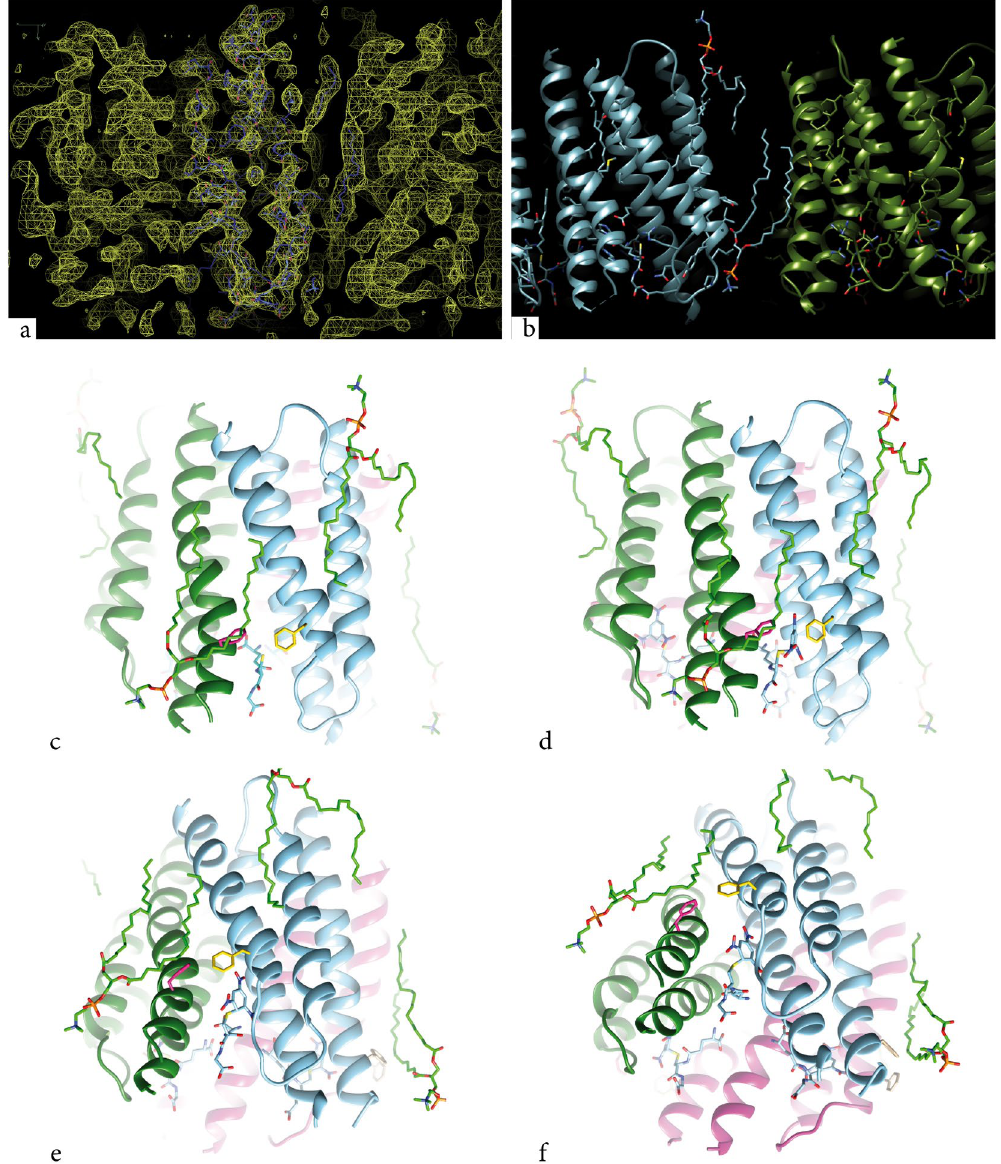
Figure 4. Two specific lipids in MGST1, one on the luminal side and one on the cytosolic side. The latter covers the putative second substrate entry path. ( a ) Side view of the 2Fo-Fc map at 1.2 σ with transmembrane helices 3 and 4 in the foreground. Parts of the two modelled phospholipids can be seen to the right of the helical domains. ( b ) Side view of two trimers of MGST1 with two phospholipid molecules at the interface. ( c ) Side view of MGST1 showing the two lipids (bright green) and GSH (cyan). F36 in magenta and F135 in yellow. ( d ) Side view of MGST1 showing the dead-end complex of GSH-TNB (light blue). ( e ) and ( f ) increasingly tilted views of MGST1 indicating that the entry path is rather closed ( e ) and the active site well within the protein trimer ( f